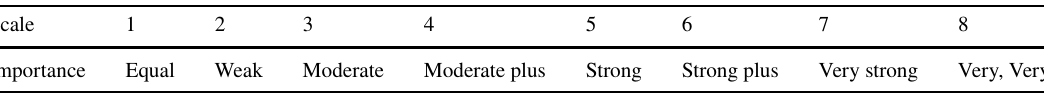
Table 3 AHP scale (Saaty 2008)